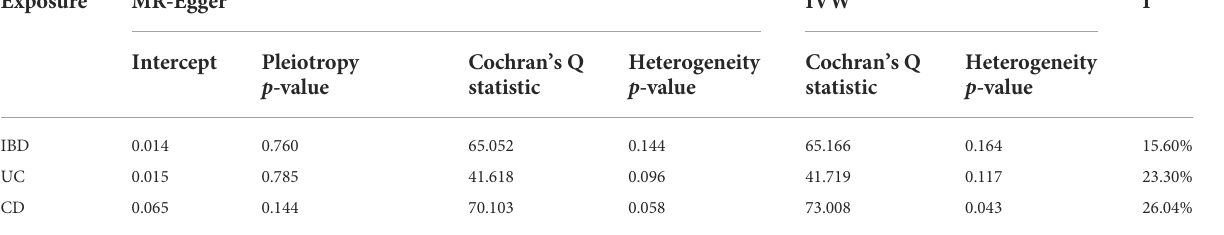
TABLE 2 Heterogeneity and pleiotropy analyses of IBD, UC, and CD with IgA nephropathy.